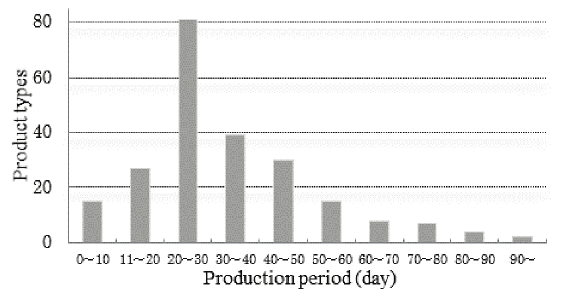
Fig. 2. Life-cycle spans of the products.